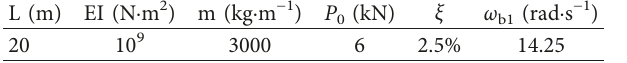
Table 2: Parameters of a bridge and moving load.